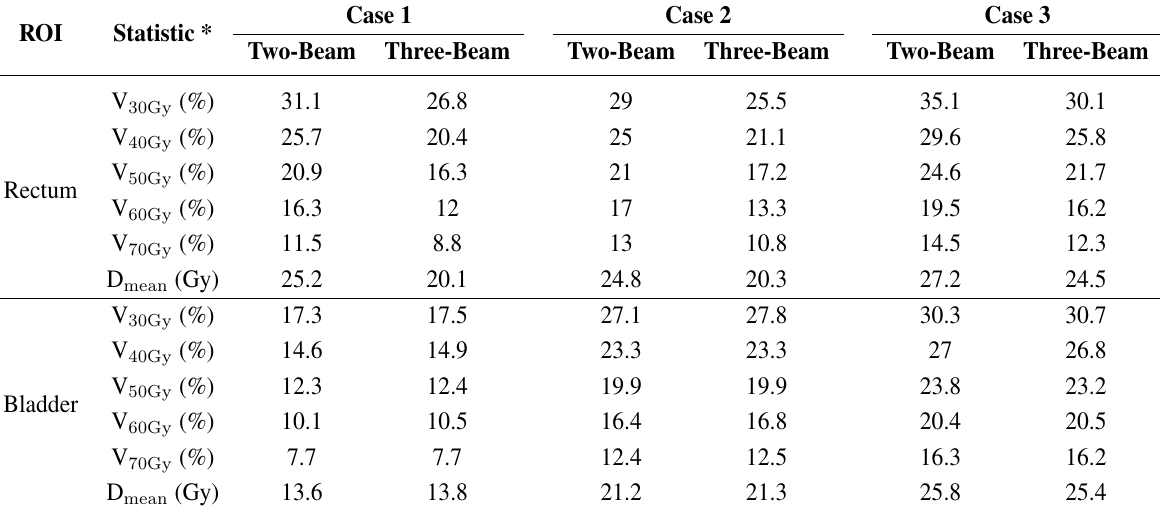
Table 2. Dose volume data for IMPT plans with conventional two beams (90 ◦ , 270 ◦ ) and class three beams (10 ◦ , 140 ◦ , 270 ◦ ) for three prostate cancer patients in the worst-case